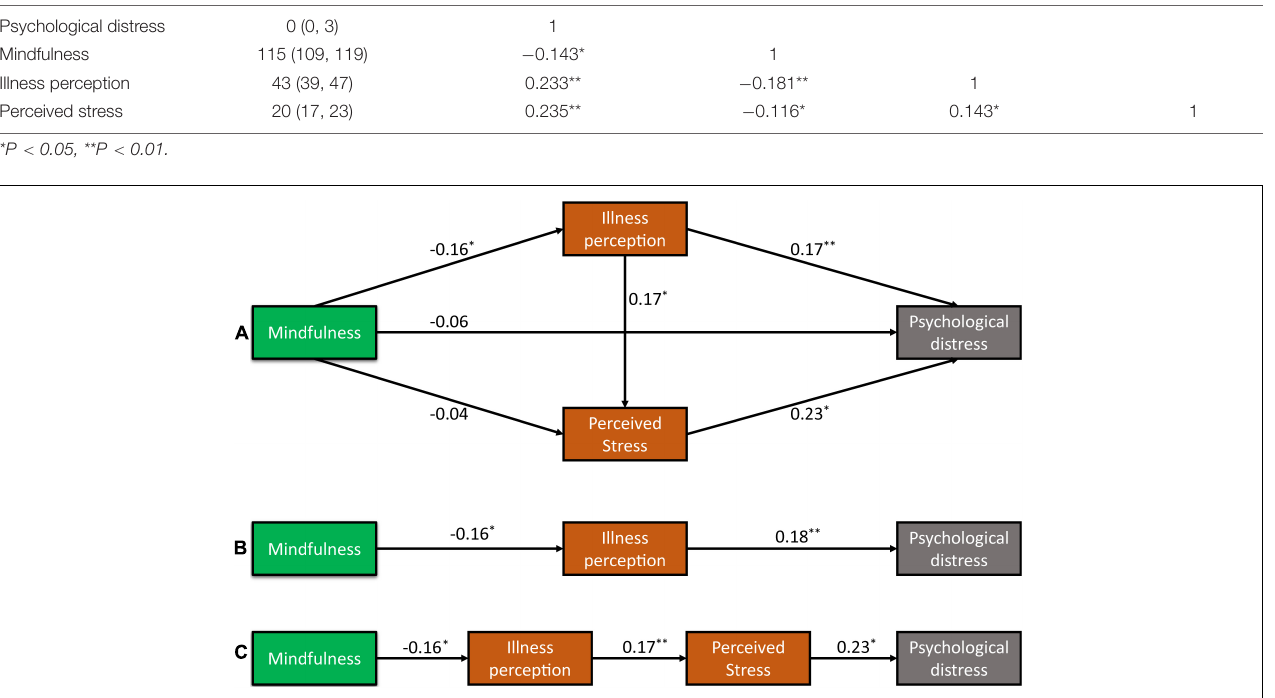
TABLE 2 | Spearman correlations for mindfulness, illness perception, perceived stress, and psychological distress. Variable Median (P 25 , P 75 ) Psychological distress Mindfulness Illness perception Perceived stress